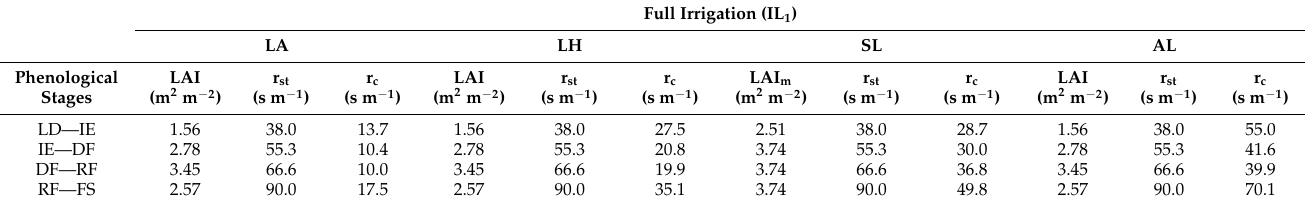
Table 1. Average values for both seasons of leaf area index (LAI), midday stomatal ( r st ) and canopy ( r c ) resistances for the empirical canopy resistance models (LA, LH, SL and AL) during the main potato phenological stages in the three irrigation levels (IL)